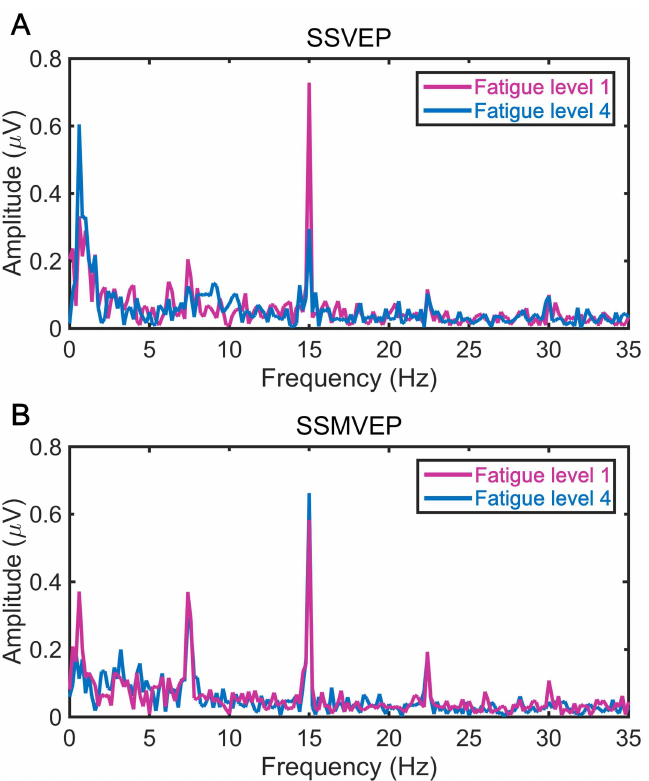
Fig 3. Grand-averaged SSVEP and SSMVEP spectra at fatigue level 1 and level 4 states over nine subjects. (A) Grand-averaged SSVEP spectrum. (B) Grand-averaged SSMVEP spectrum. Fatigue level 1: spectral power calculated from the first five epochs of each run in SSVEP-BCI and SSMVEP-BCI tasks; Fatigue level 4: spectral power calculated from the last five epochs of each run.